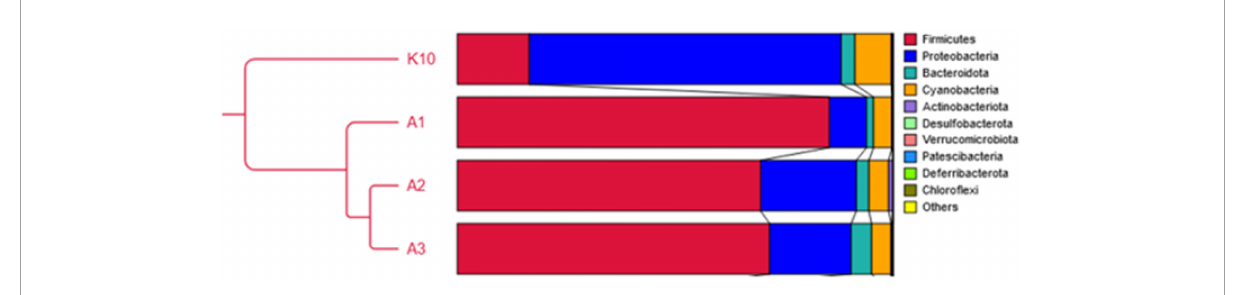
FIGURE6 Relative abundance of bacteria at a phylum level. K10, non-fermented sample; A1, sample fermented by P. acidilactici ; A2, fermented by L. plantarum ; A3, fermented by L. uvarum .